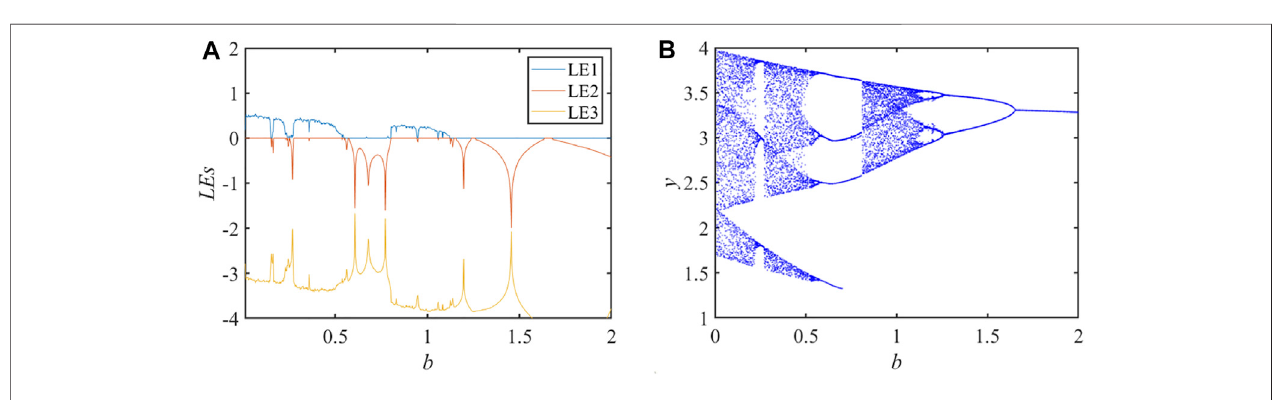
FIGURE 4 | Dynamical analysis with parameter b , (A) LEs, (B)